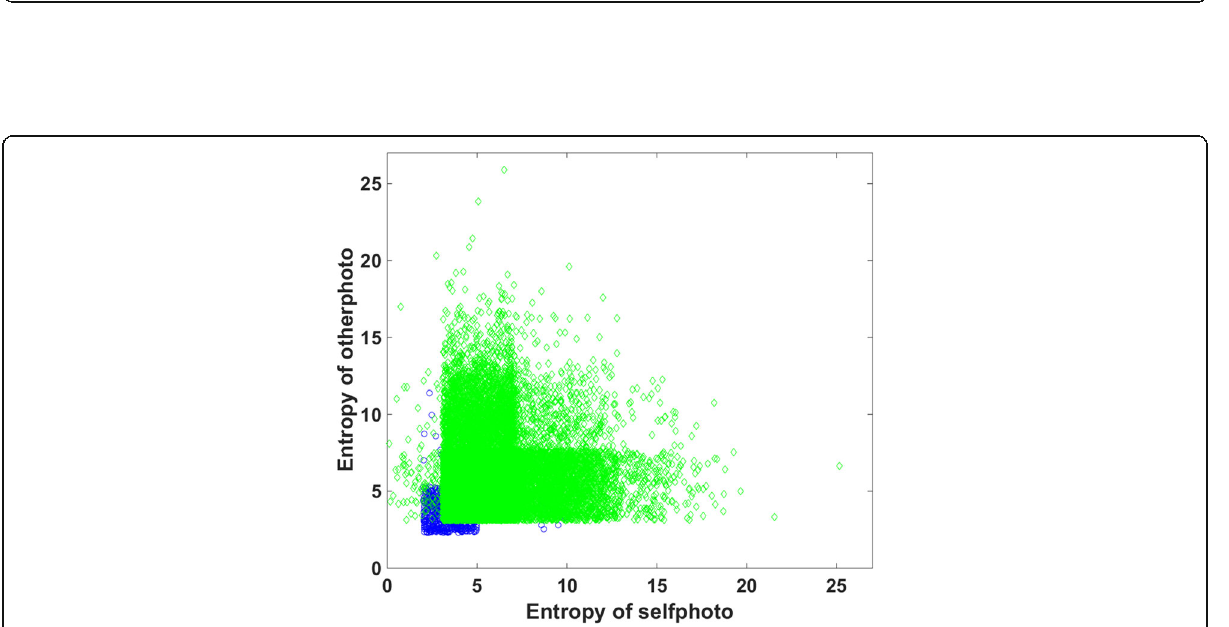
Fig. 3 Comparison of entropy values of different stimuli. Blue is a black-and-white photo source, green is a photo source, the x -axis is the entropy value of 9 pictures, and y is the entropy value of 9 pictures